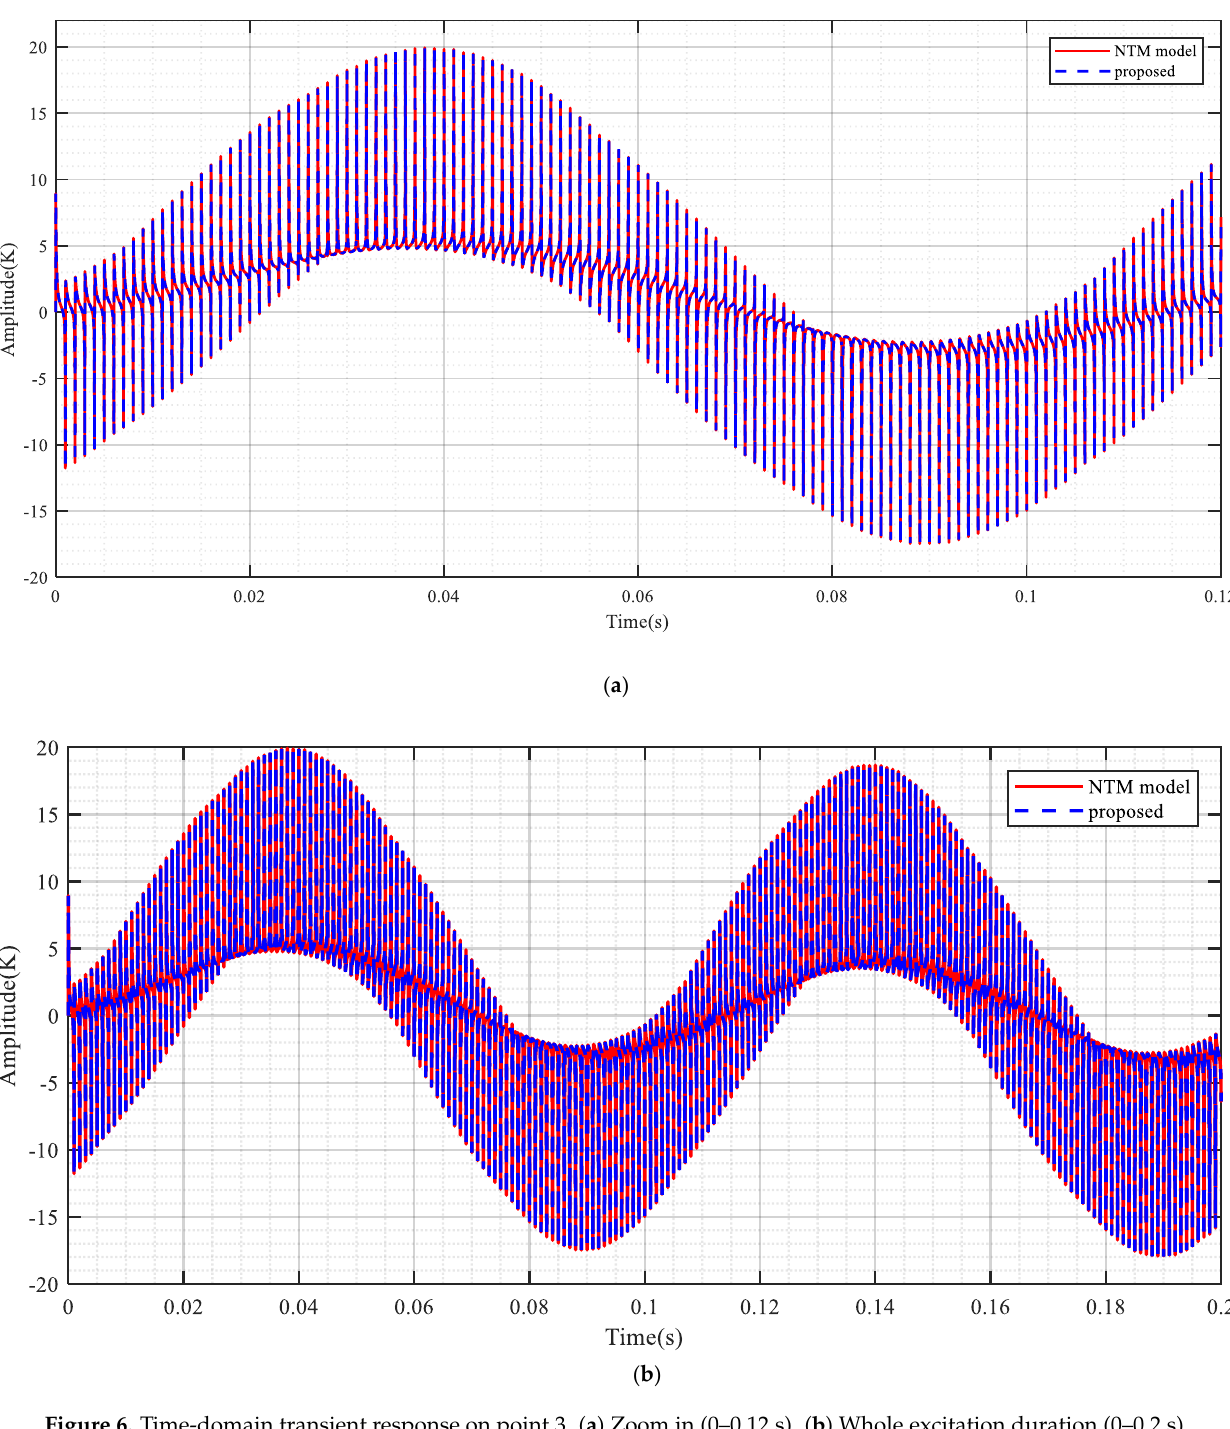
Figure 6. Time-domain transient response on point 3. ( a ) Zoom in (0 – 0.12 s). ( b ) Whole excitation duration (0 – 0.2 s).